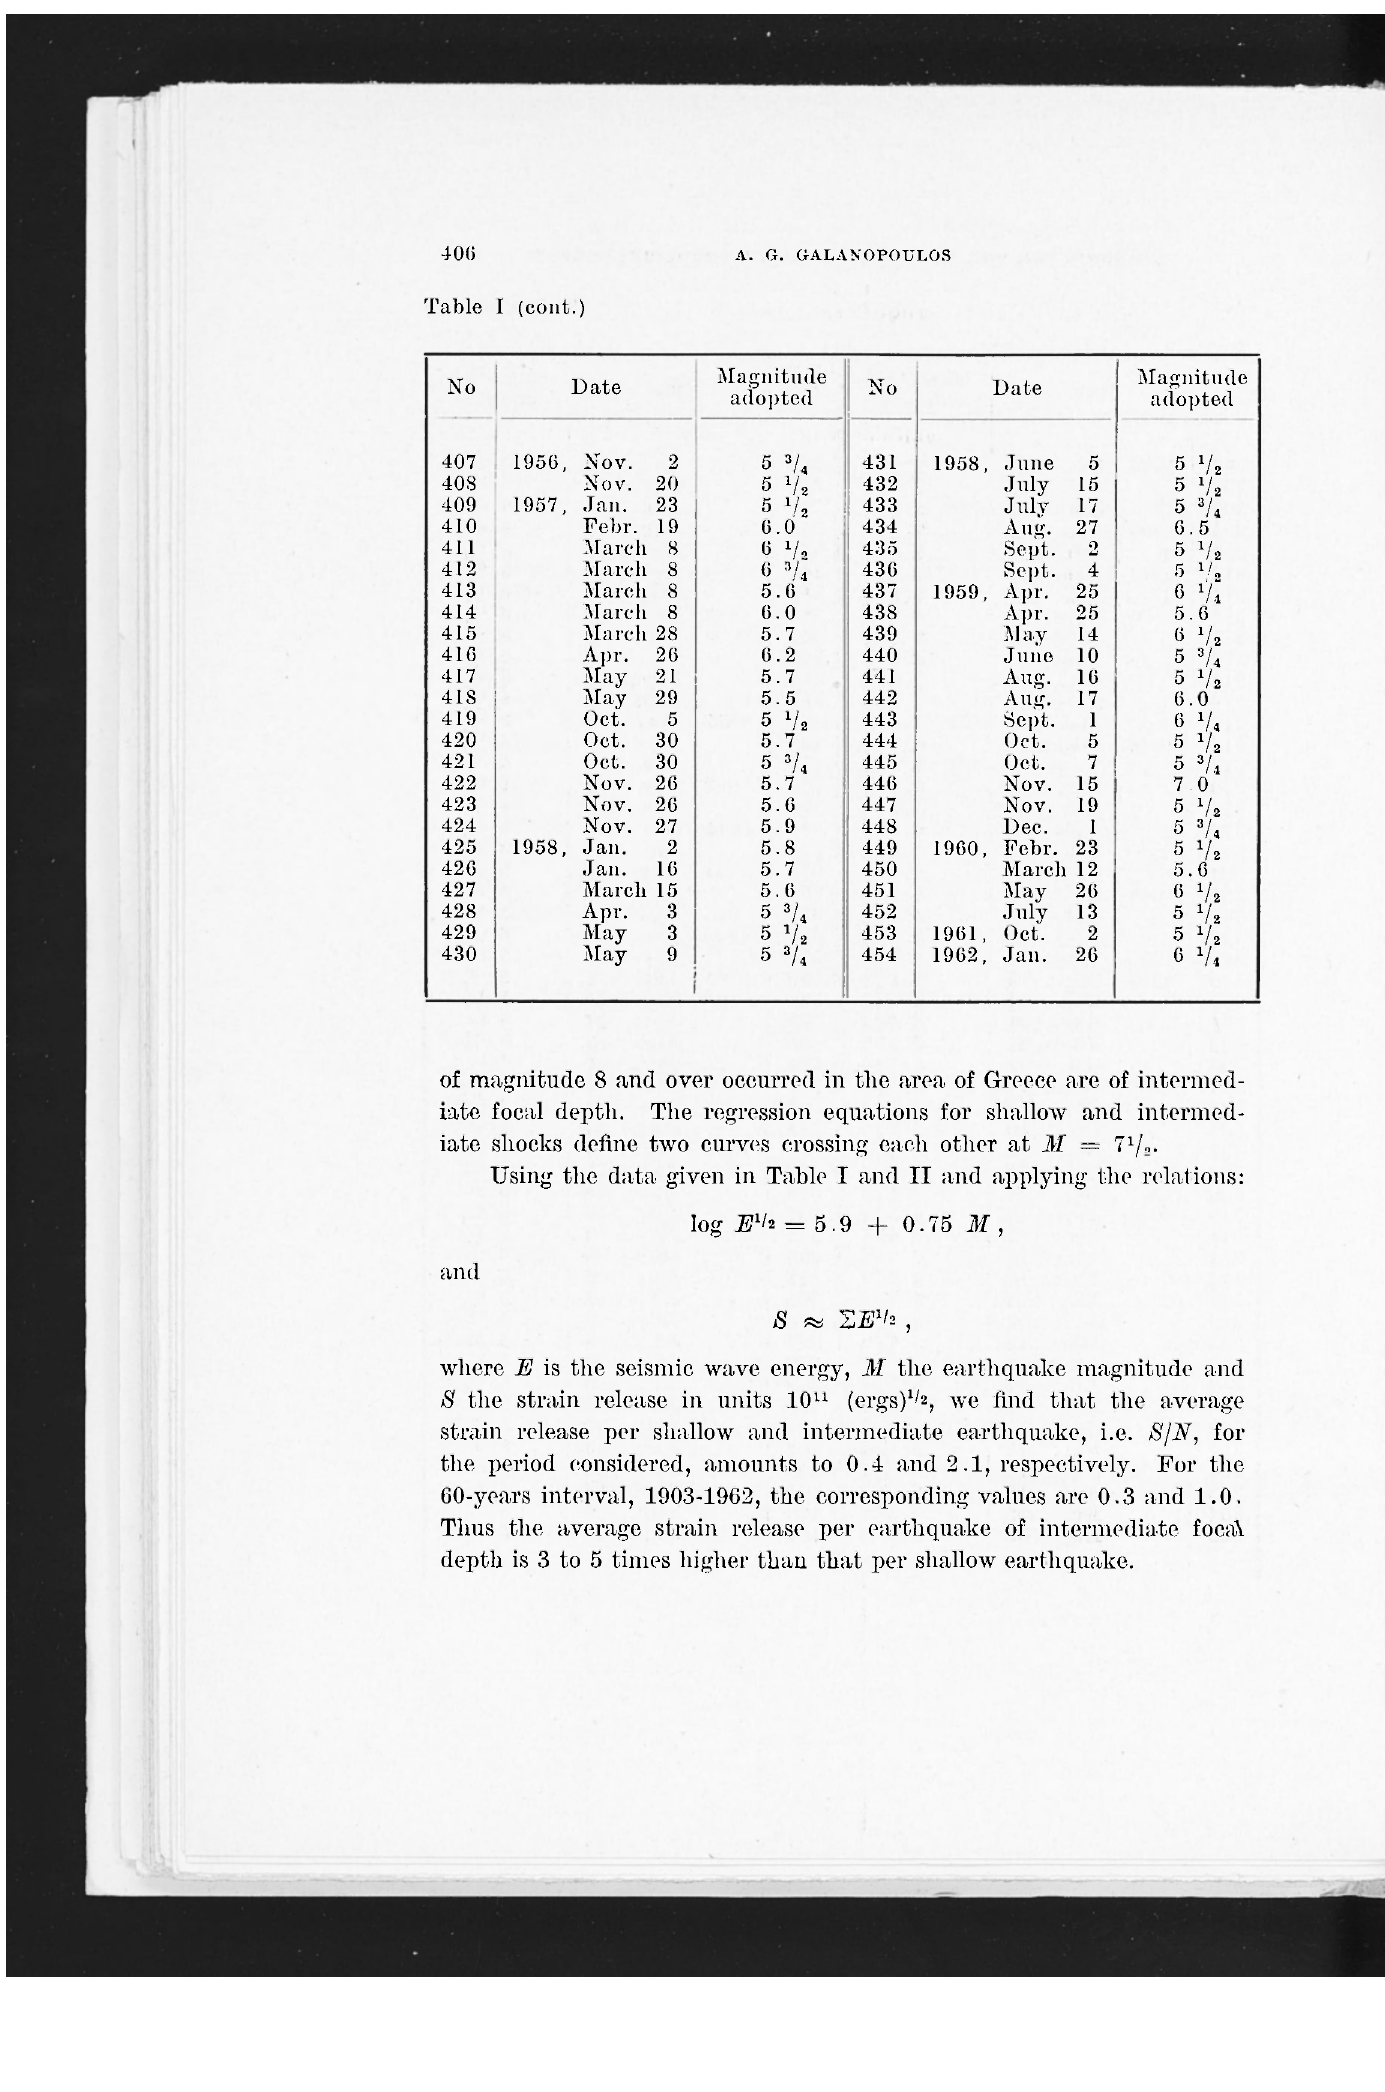
depth is 3 to 5 times higher than that per shallow